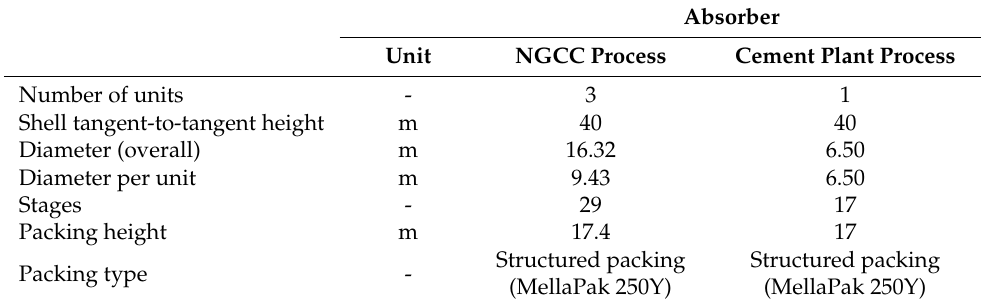
Table 8. Absorber dimensioning data.